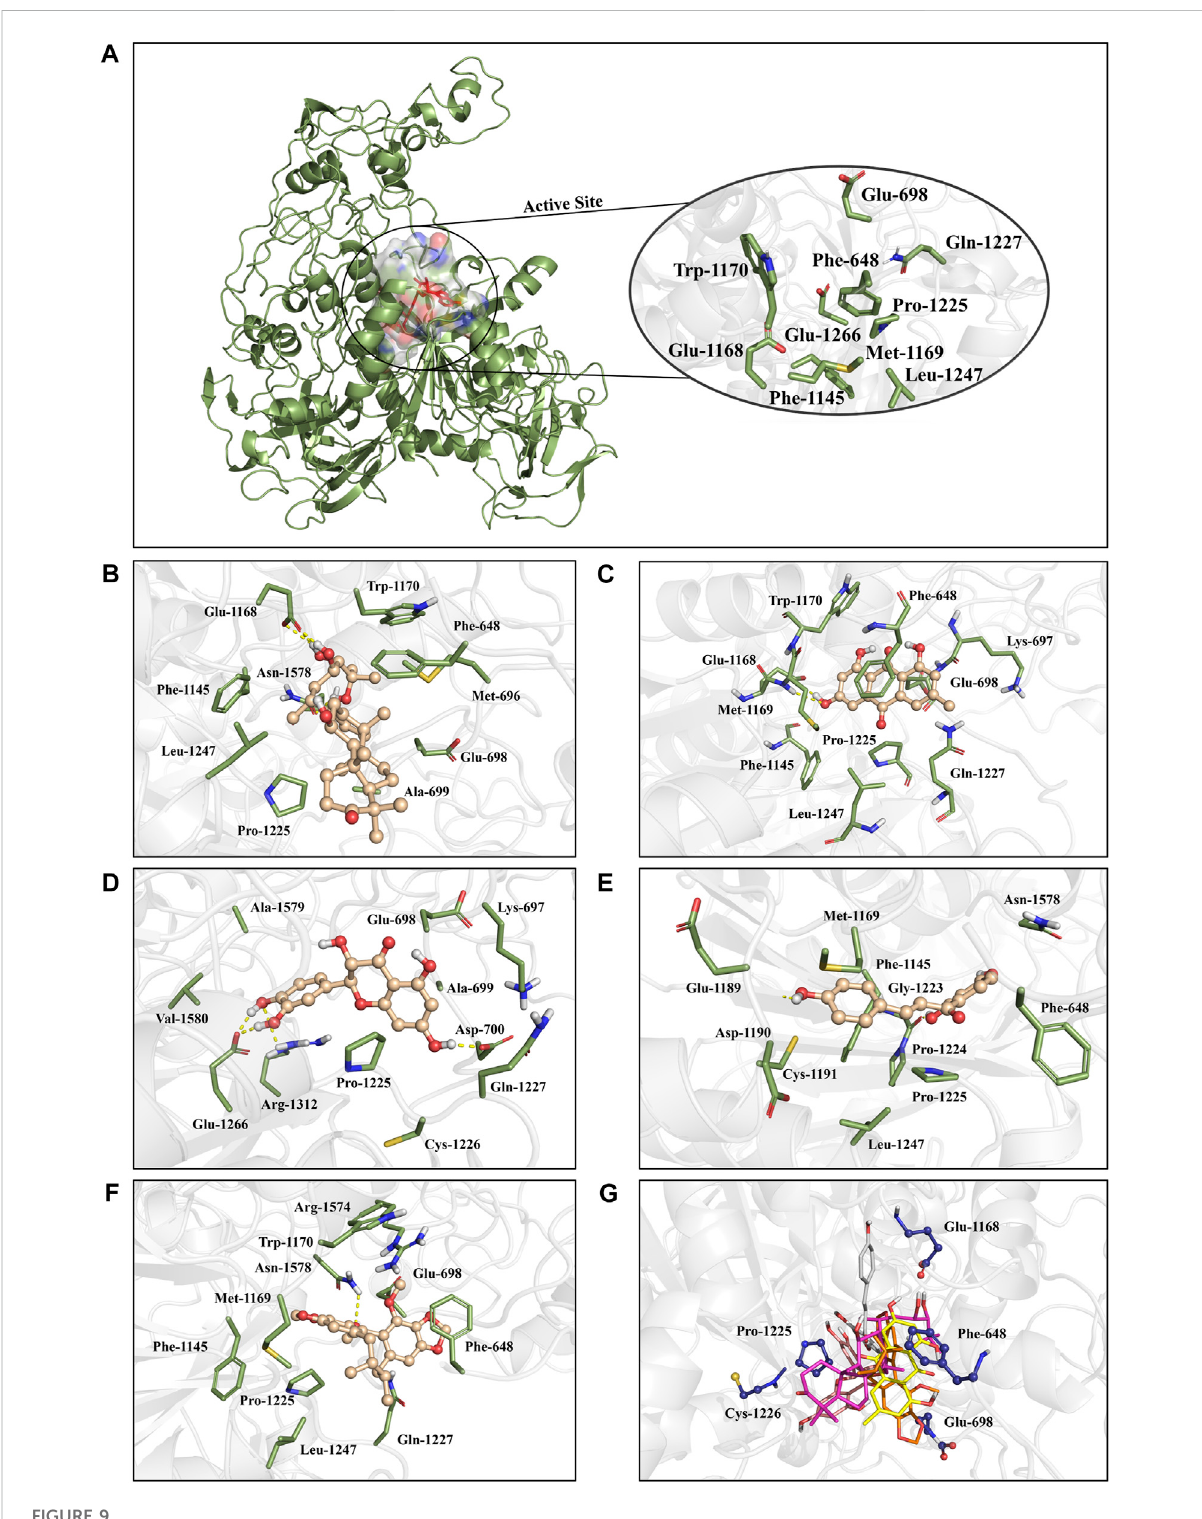
FIGURE 9 The positions of the active constituents are anchored by the interaction with DNMT1. (A) The complex structure and active site of DNMT1. The active site of DNMT1 was shown in rainbow surface. (B) Interaction mode of alisol A with the DNMT1; (C) Interaction mode of emodin with the DNMT1; (D) Interaction mode of taxifolin with the DNMT1; (E) Interaction mode of isoliquiritigenin with the DNMT1; (F) Interaction mode of schisandrin C; and (G) above fi ve constituents with the